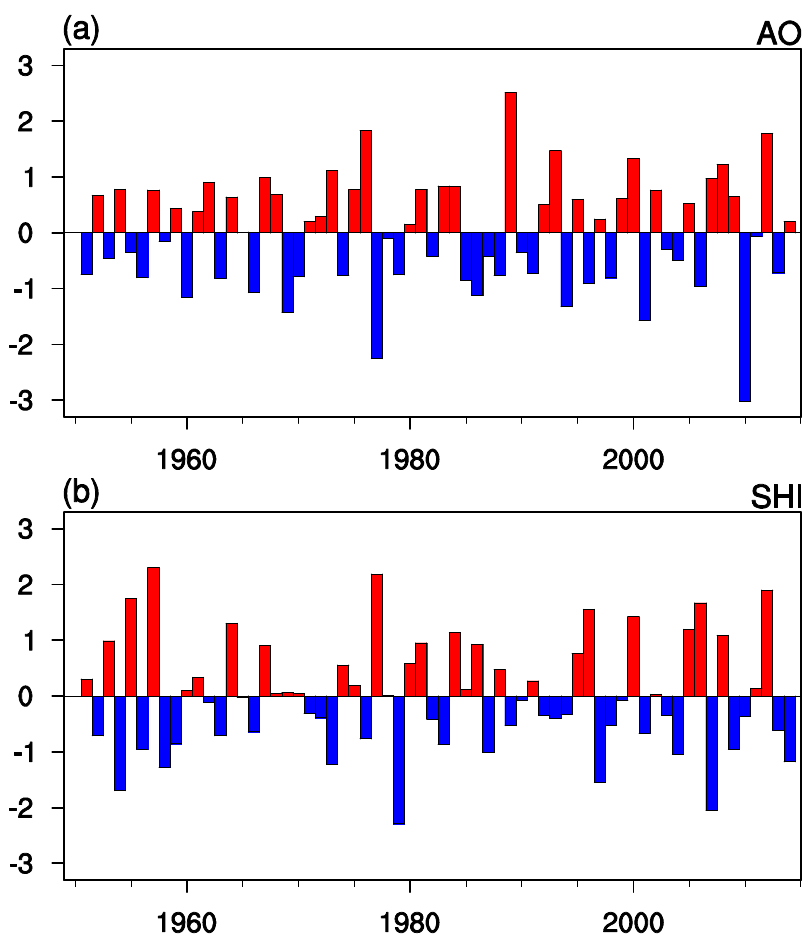
Figure 1. Normalized time series of ( a ) AO and ( b ) Siberian High (SH) indices at boreal winter (DJF-averaged) during 1951–2014.